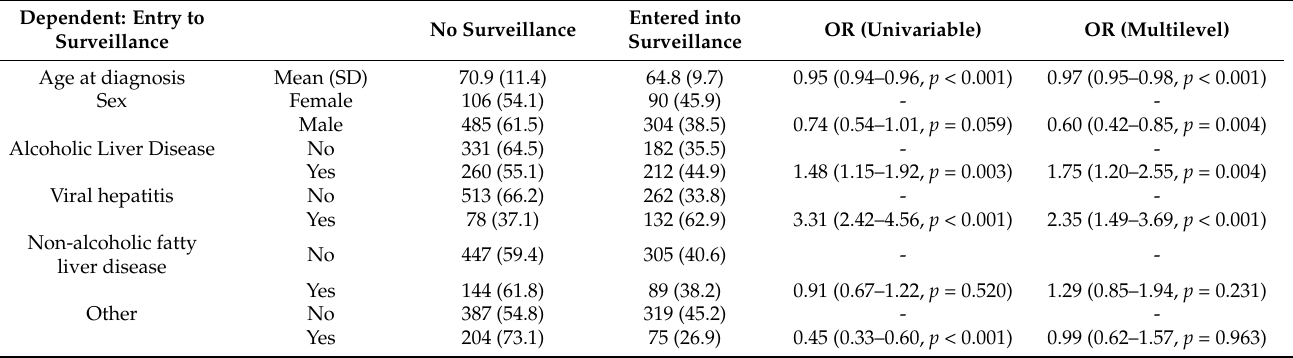
Table 2. Model for surveillance group membership (entry to